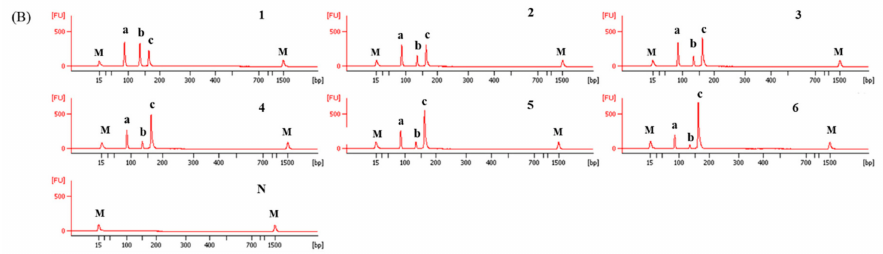
Figure 5. Detection limits of red deer and roe deer in water deer by the multiplex PCR assay. Gel image ( A ) and electropherograms ( B ). FU: fluorescence, M: alignment marker, lane L: 100 bp DNA ladder, lane 1: positive control (10 ng of DNA from target species), lanes 2–6: 10, 5, 1, 0.5, and 0.1% red deer and roe deer in water deer, and lane N: non-template. a, b, and c indicate red deer, roe deer, and water deer, respectively. Foods 2020 , 9 , x FOR PEER REVIEW 10 of 12